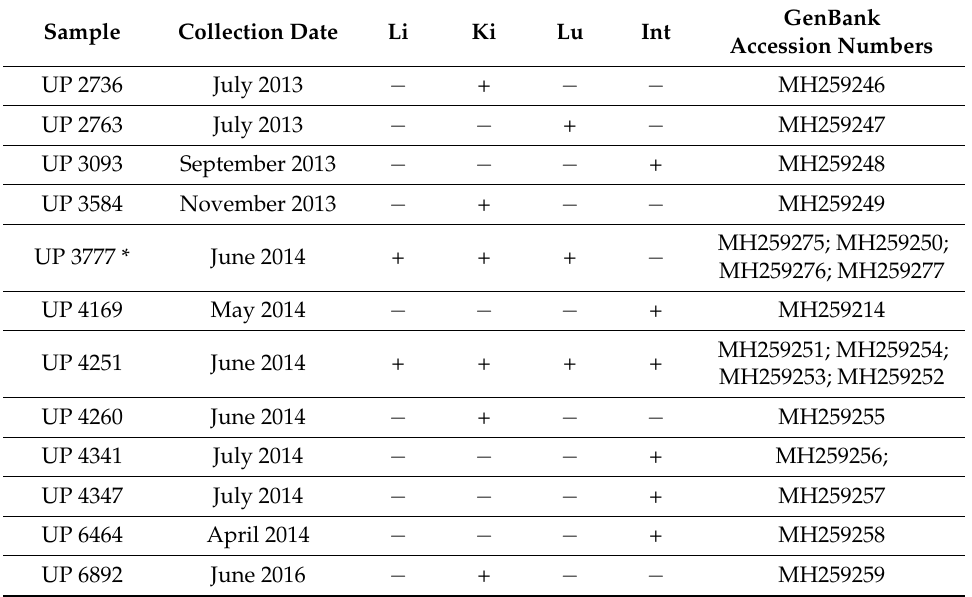
Table 2. Paramyxovirus RNA detection in additional organs of bats that tested rubulavirus-positive in spleen